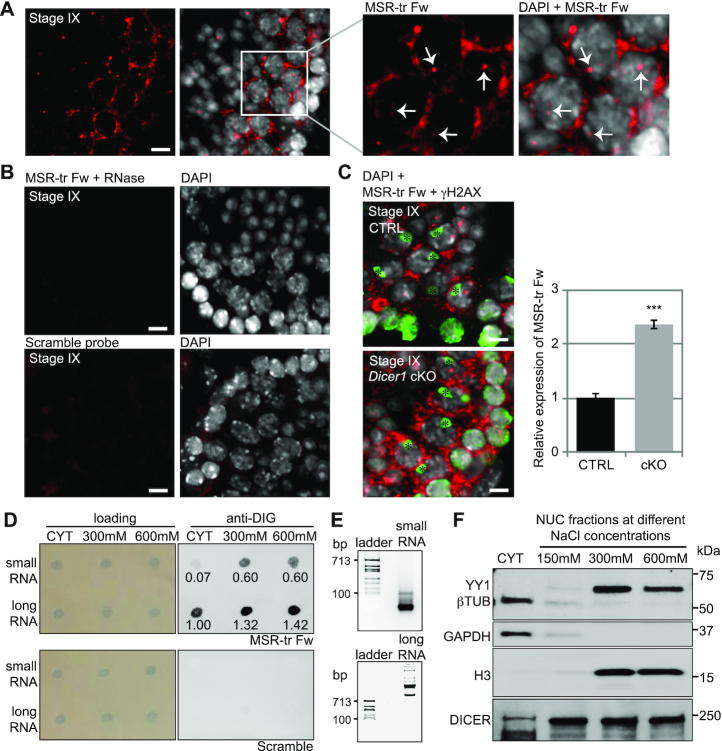
DICER and major satellite repeat transcripts associate with chromatin. (A) In situ hybridization using a LNA probe for the forward strand-derived MSR transcripts (MSR-tr Fw, red) on WT testis cryosections. Strong signal was detected in the cytoplasm of late pachytene spermatocytes at stage IX of the seminiferous epithelial cycle. MSR-tr signal was also detected in the nucleus (arrows). Nuclei were stained by DAPI (grey). (B) The forward MSR transcript signal disappeared when the sections were treated with RNase prior to hybridization, demonstrating that the signal originated from RNA transcripts. No signal was detected using a scramble probe. Scale bars for A and B: 10 μm. (C) Relatively stronger expression of the forward MSR transcripts (red) was detected by in situ hybridization in Dicer1 cKO spermatocytes compared to the control. To facilitate the recognition of pachytene spermatocytes, the sections were immunostained using an antibody against phosphorylated gamma-H2AX (γH2AX, green), which detects double-strand breaks and labels the sex body (asterisks) in pachytene spermatocytes. Scale bar: 10 μm. The graph shows quantification of average signal intensity of cytoplasmic MSR Fw transcripts signal in CTRL and Dicer1 cKO pachytene spermatocytes. The signal was quantified from three independent technical replicates (15–20 cells each); SEM, ***P< 0.001. See also Supplementary Figure S1G. (D) Chromatin fractionation was performed from nuclear extracts of 18 dpp mouse testicular cells using increasing concentrations of NaCl, and RNA was extracted from the cytoplasmic fraction as well as from 300 mM and 600 mM NaCl chromatin fractions. MSR transcripts were detected separately from long (>200 nt) or short (<200 nt) RNA fraction with the LNA probe against the forward MSR transcript. Long MSR transcripts were found both in the cytoplasmic and chromatin fractions, while MSR transcript-derived small RNAs were mainly detected in the chromatin fractions. The numbers below the anti-DIG signal indicate relative intensities of MSR-tr Fw signal quantified by ImageJ. The signal intensities are shown relative to the cytoplasmic long RNA sample that was set as ‘1’. (E) Separation of total RNA into long and small RNA fractions was validated by agarose gel electrophoresis followed by ethidium bromide staining. (F) Immunoblotting of cytoplasmic and chromatin fractions with anti-DICER antibody demonstrated the presence of DICER in all fractions. Cellular fractions were validated by immunoblotting with antibodies against cytoplasmic proteins (β-TUBULIN, GAPDH) and chromatin-associated proteins (YY1, H3). All panels show a representative figure of an experiment that was independently repeated at least two times.